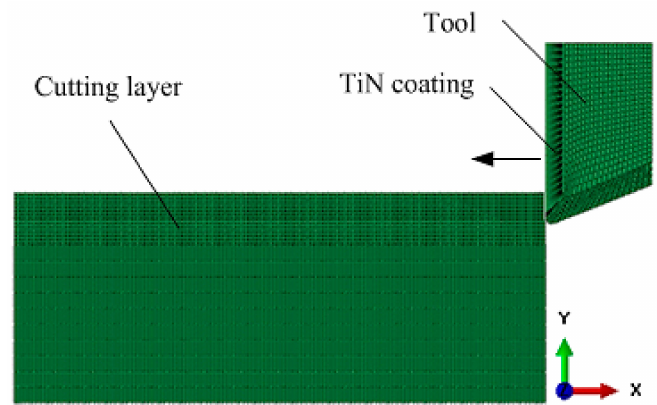
Figure 6. Orthogonal finite element cutting model of gray cast iron.